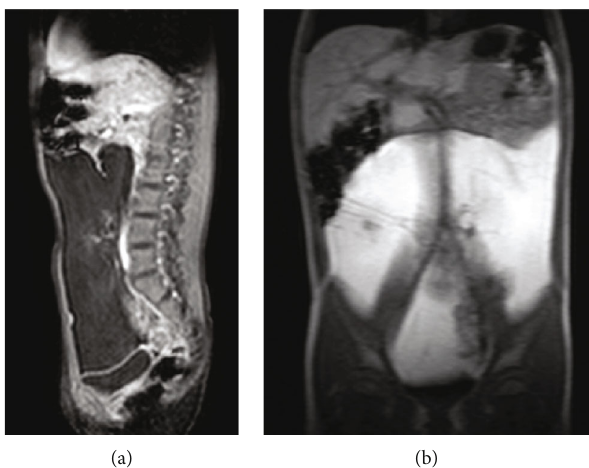
Figure 1: (a, b) MRI ((a) T1 weighted, (b) Thrive sequences) showing the mass occupying the entire abdominal cavity, compressing and displacing the bowel, the inferior vena cava, and common iliac veins.